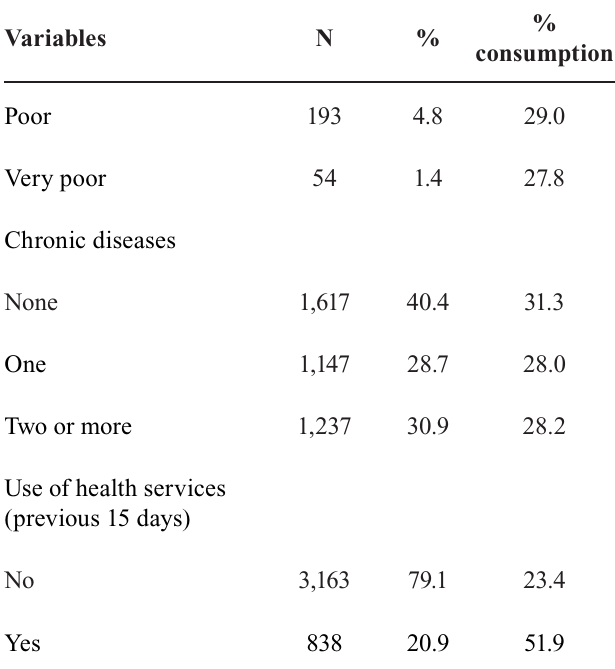
TABLE I - Characteristics of the population and frequency of use of medicines in the 15 days prior to data collection, Manaus Metropolitan Region, 2015 (n=4,001)